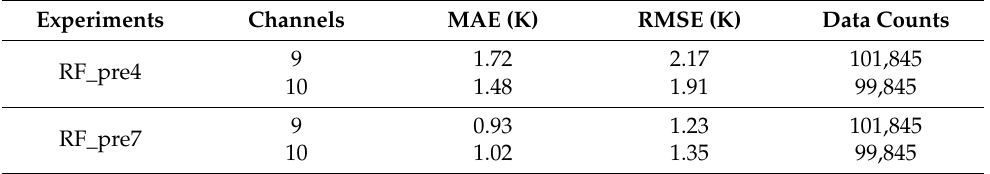
Table 2. The RF model prediction scores of two different experiments.